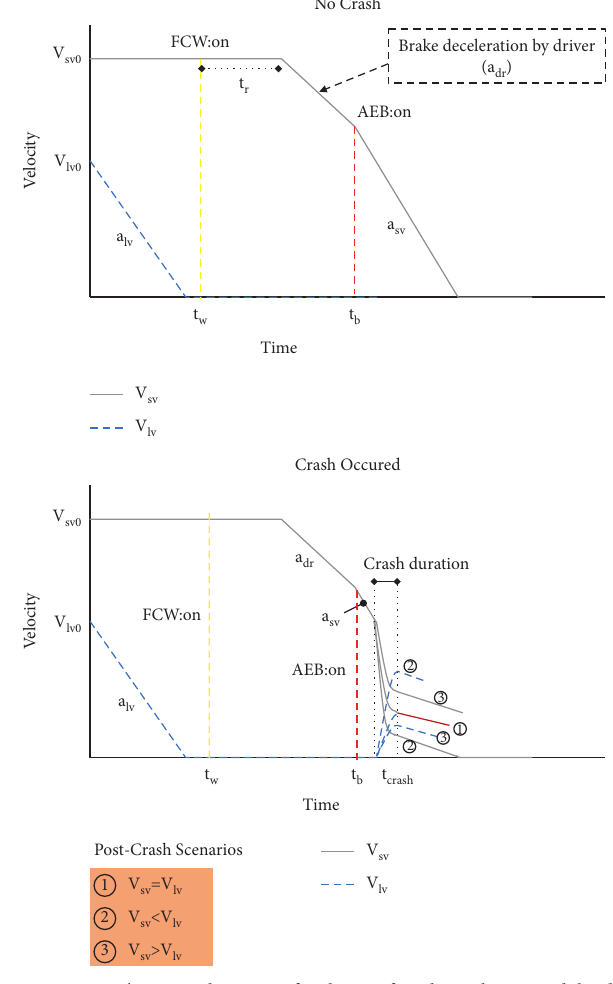
Figure 3: The time history of velocity for the subject and lead vehicles in the typical car-following situation for the crash and noncrash scenario. (a) No crush. (b) Crush